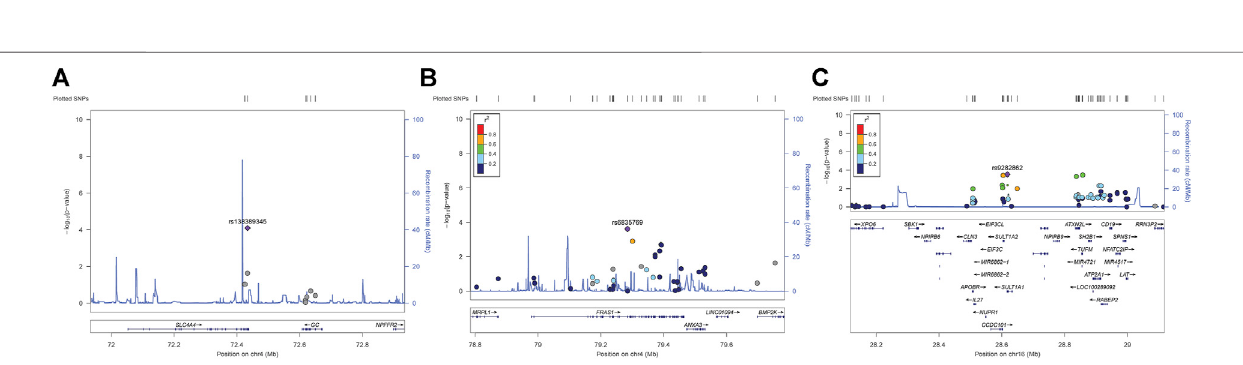
FIGURE2 | Regional associationplots ofsuggestiveSNPs on AUC 0 – t offreedabigatran. (A) SLC4A4 SNP rs138389345 (B) FRAS1 SNP rs6835769 (C) SULT1A SNP rs9282862. Annotation: SNPs are shown according to their physical location and – log 10 p -values for association. Also shown is the recombination rate in centimorgans per megabase (blue line) and the linkage disequilibrium ( r 2 ) of each SNP with the SNP having the lowest p